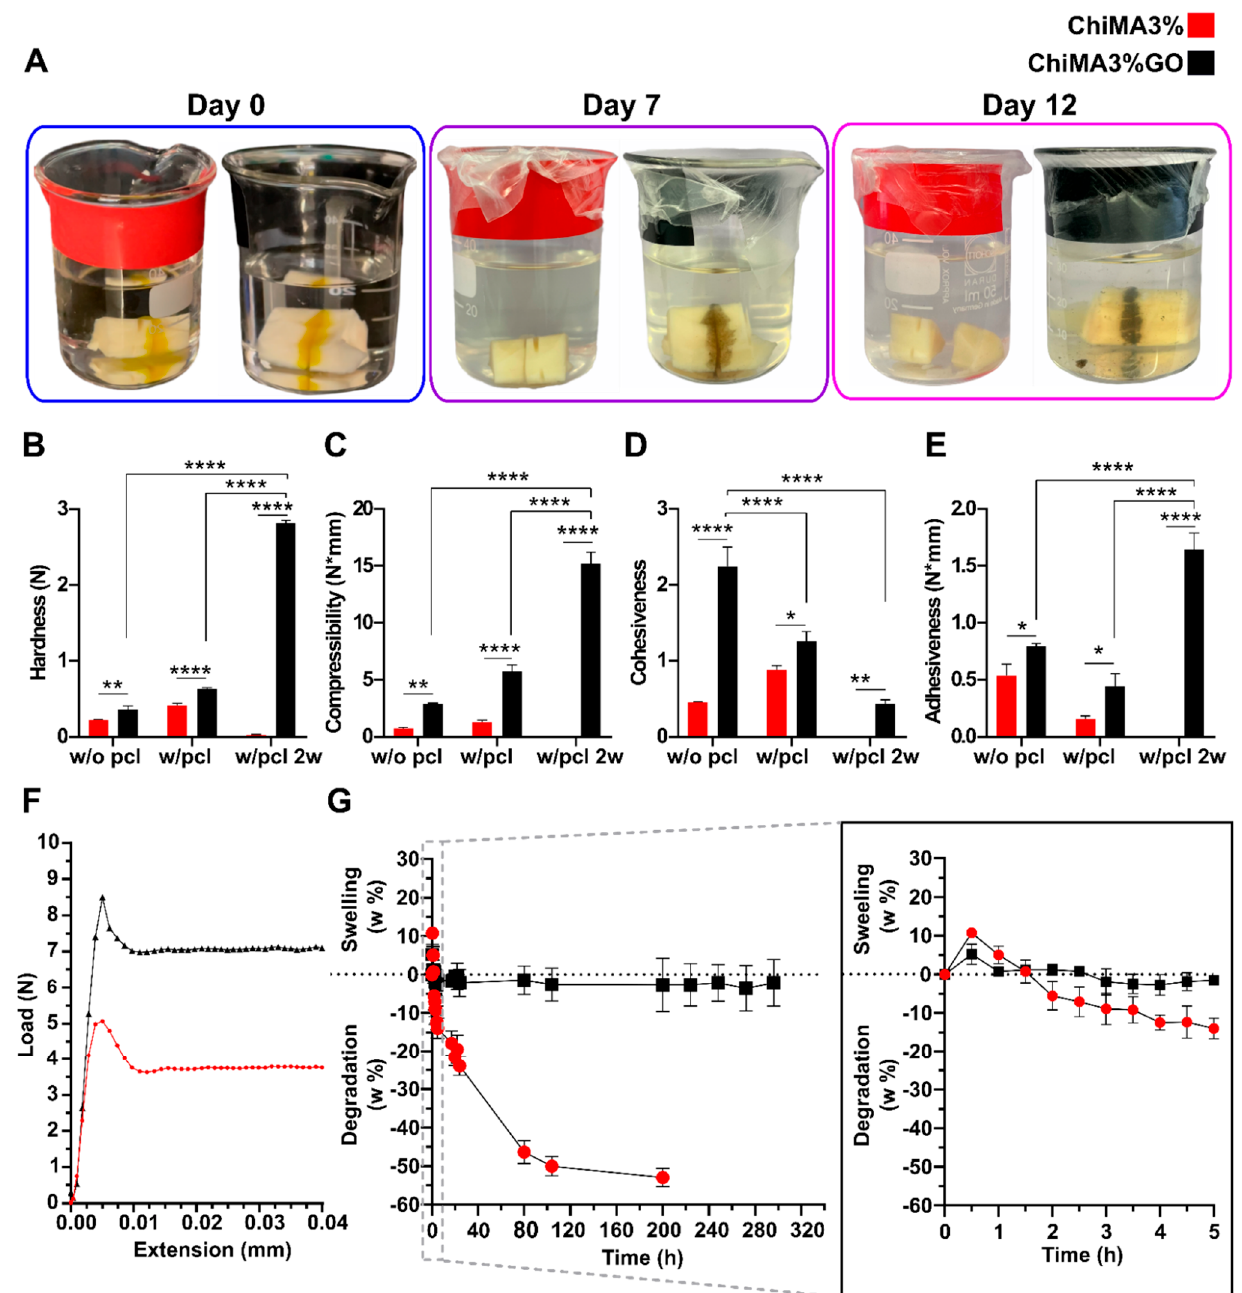
Figure 8. Mechanical and adhesive evaluation of the ChiMA3% and ChiMA3%GO hydrogel s . ( A ) Qualitative adhesion of bone specimens at 0, 7, and 12 days. ( B ) Hardness, ( C ) compressibility, ( D ) cohesiveness, and ( E ) adhesiveness of the hydrogels before and after photocrosslinking and 2-weeks of incubation at 37 °C (two-way ANOVA * P ≤ 0.05 ** P ≤ 0.01 *** P ≤ 0.001 **** P ≤ 0.0001). ( F ) Tensile strength of butt-joint specimens. ( G ) Swelling and degradation of the hydrogels.